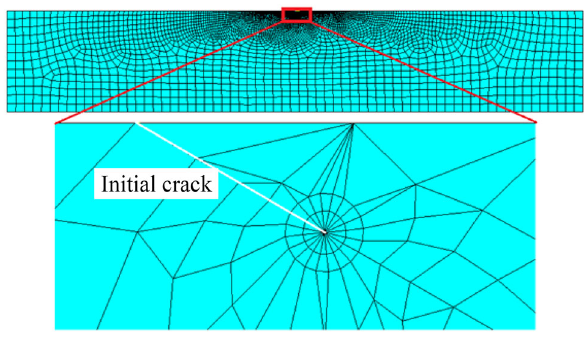
Fig. 3 Finite element model of rail crack